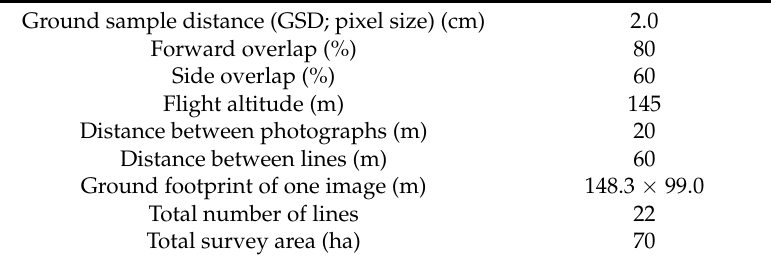
Table 3. Technical specification of flight planned over the Kłodne landslide.